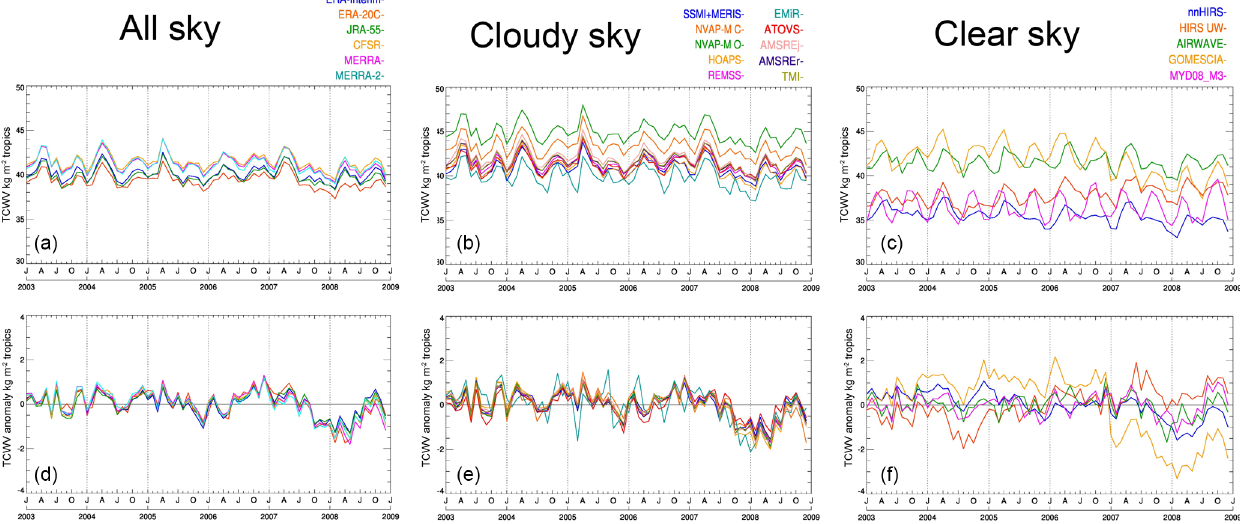
Figure 4. Time series (January 2003–December 2008) of TCWV (a, b, c) and TCWV anomalies (d, e, f) for the tropics ( ± 20 ◦ N/S) over ocean for the predominant retrieval condition classes all-sky (a, d) , cloudy-sky (b, e) and clear-sky (c, f) . MERIS is not shown because it is not defined over ocean. Partly the legends include unambiguous abbreviations of the data record names, with the following exceptions: AMSR-E JAXA (AMSREj), AMSR-E REMSS (AMSREr), Merged Microwave REMSS